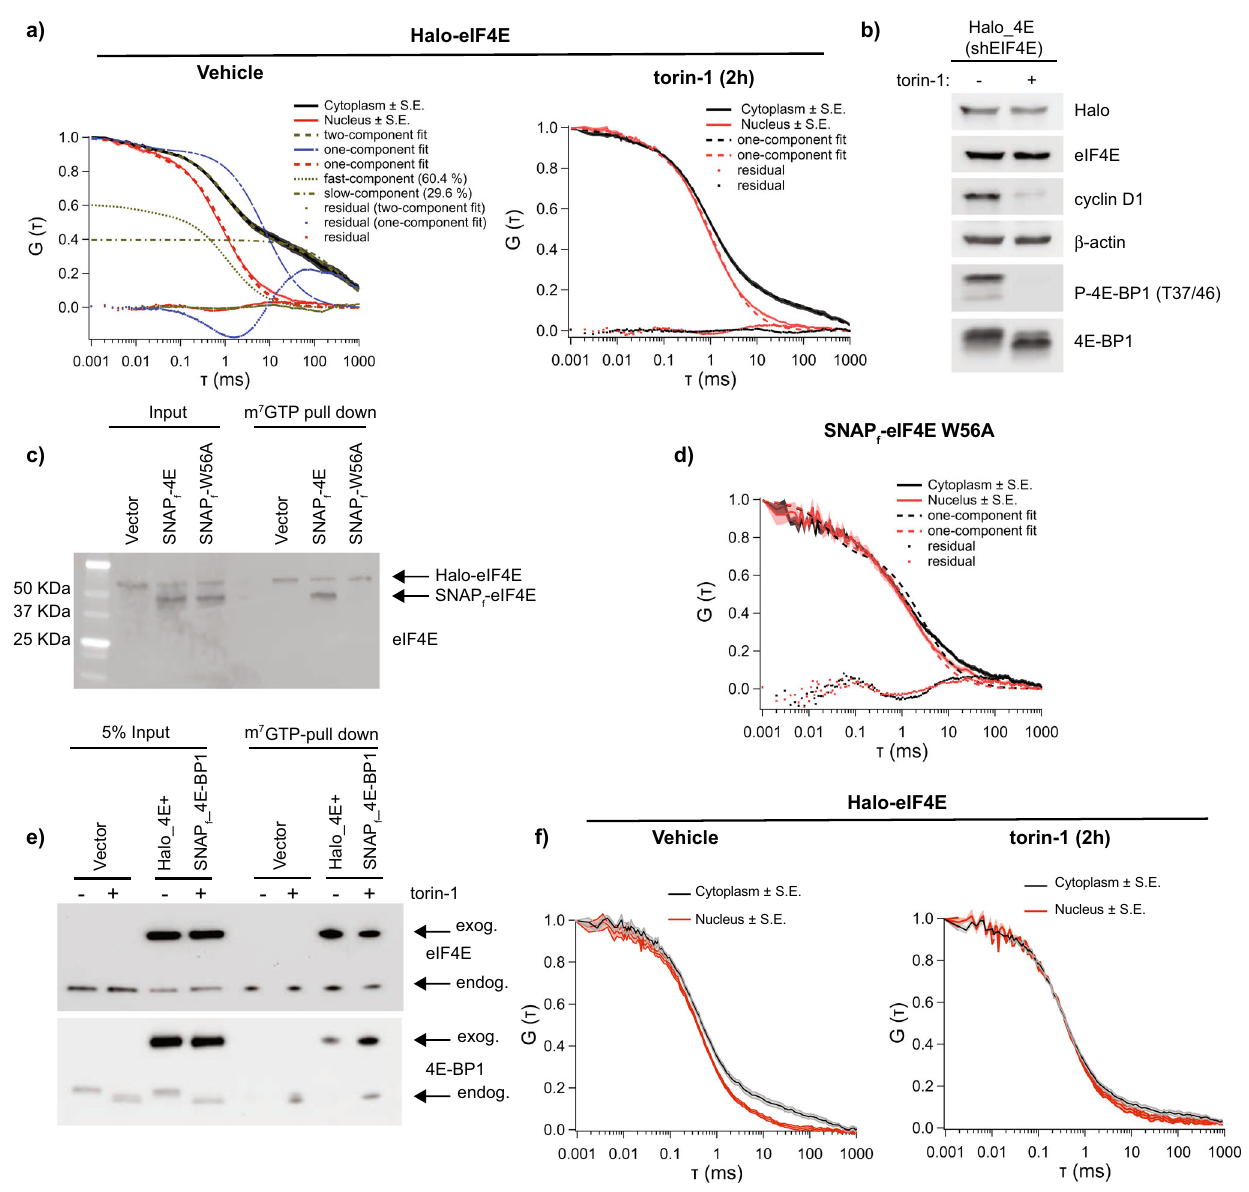
Fig. 1 | Binding of exogenous Halo-eIF4E to the 5 ’ cap is detected by FCS. a NIH3T3 cells that express Halo-eIF4E, in which the endogenous counterpart was silenced by shRNA, were treated for 2h with vehicle (DMSO) or 250nM torin-1. Averaged autocorrelation curves show temporal diffusion of Halo-eIF4E molecules (ms=milliseconds)inthecytoplasm(black)andinthenucleus(red)intheindicated conditions ( N =10±SEM). Halo-eIF4E diffusion is slower in translating cells as comparedtocellstreatedwithtorin-1.Cytoplasmicautocorrelationbest fi twithtwo components (fast – dark yellow dotted curve: τ fast =1.14±0.03ms, and slow – dash- dotted curve: τ slow =372.69±10.8ms). Percentages of slow ( D slow =0.05 μ m 2 /s) and fast ( D fast =14.78 μ m 2 /s) moving molecules are indicated. While one-component fi ts nuclear Halo-eIF4E well (see red curves), a one-component fi t (see the blue dashed curve, with dotted fi t residual) cannot adequately describe the cytoplasmic Halo- eIF4E autocorrelation curve. b Total cell lysates from the cells described in ( a ) were analyzed by western blotting withthe indicated antibodies. 4E-BPs phosphorylation